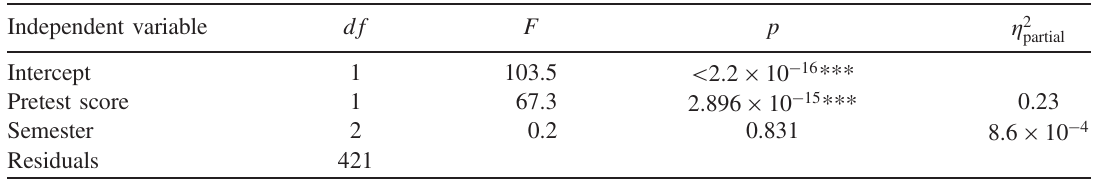
TABLE XII. Results of one-way ANCOVA (type III) conducted on student performance on FCI posttest in Physics I with semester as an independent variable and pretest score as a covariate. Heteroscedasticity correction was conducted.